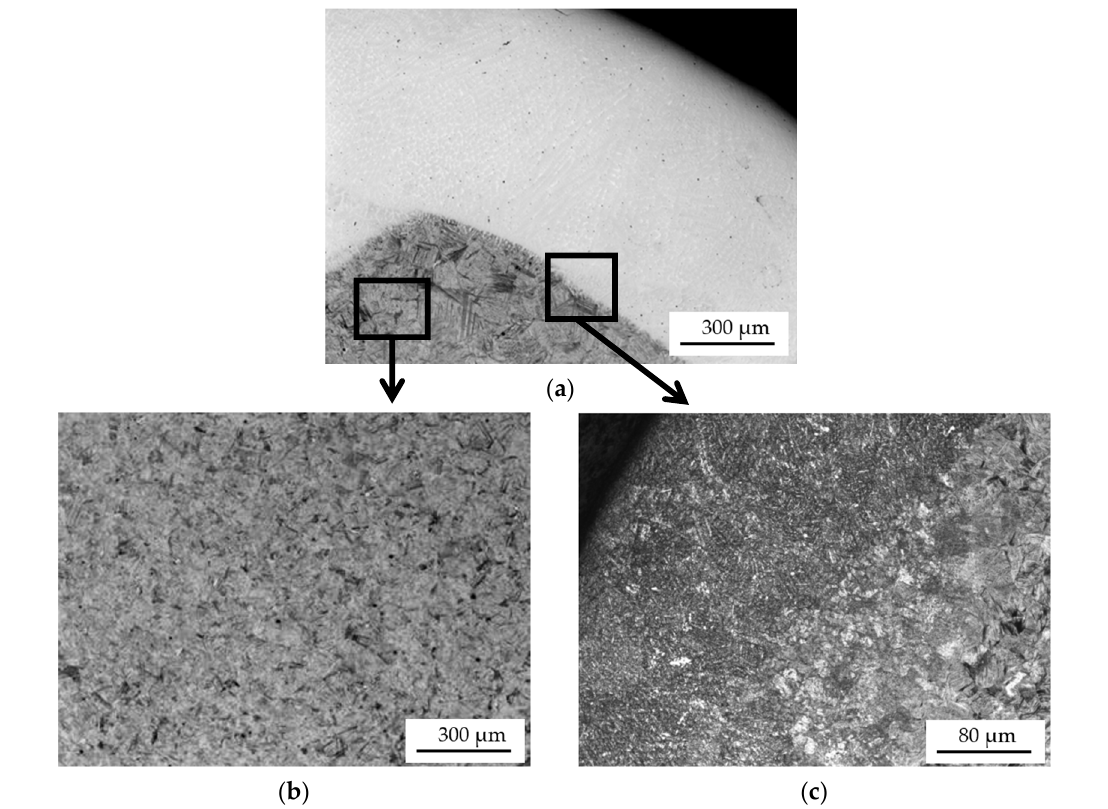
Figure 9. Microstructure of a cross-section of a turbocharger shaft journal after two-layer hardfacing: bright padding weld coating (etched with 4% nital) ( a ), microstructure of the shaft journal core ( b ), transition zone: coating—material (etched with Kalling’s reagent) ( c ).